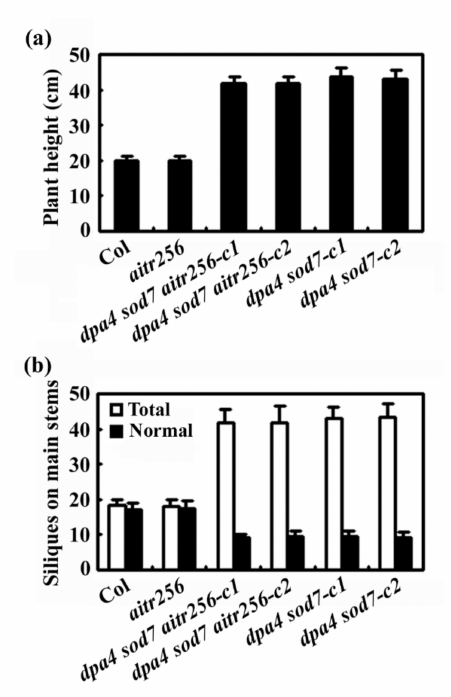
Figure 6. Height and siliques of the dpa4 sod7 aitr256 quintuple and the dpa4 sod7 double mutants. ( a ) Height of 12-week-old Col wild type, the aitr256 triple, the dpa4 sod7 aitr256 quintuple and dpa4 sod7 double mutants. ( b ) Siliques of Col wild type, the aitr256 triple, the dpa4 sod7 aitr256 quintuple and dpa4 sod7 double mutants. Seeds of the Col wild type, the aitr256 triple, the dpa4 sod7 aitr256 quintuple and the dpa4 sod7 double mutants were generated and grown in soil pots for 12 weeks, plant height was measured, total siliques and siliques with seeds (normal siliques) on the main inflorescence stems of the plants were counted. Data represent the mean ± SD of at least 11